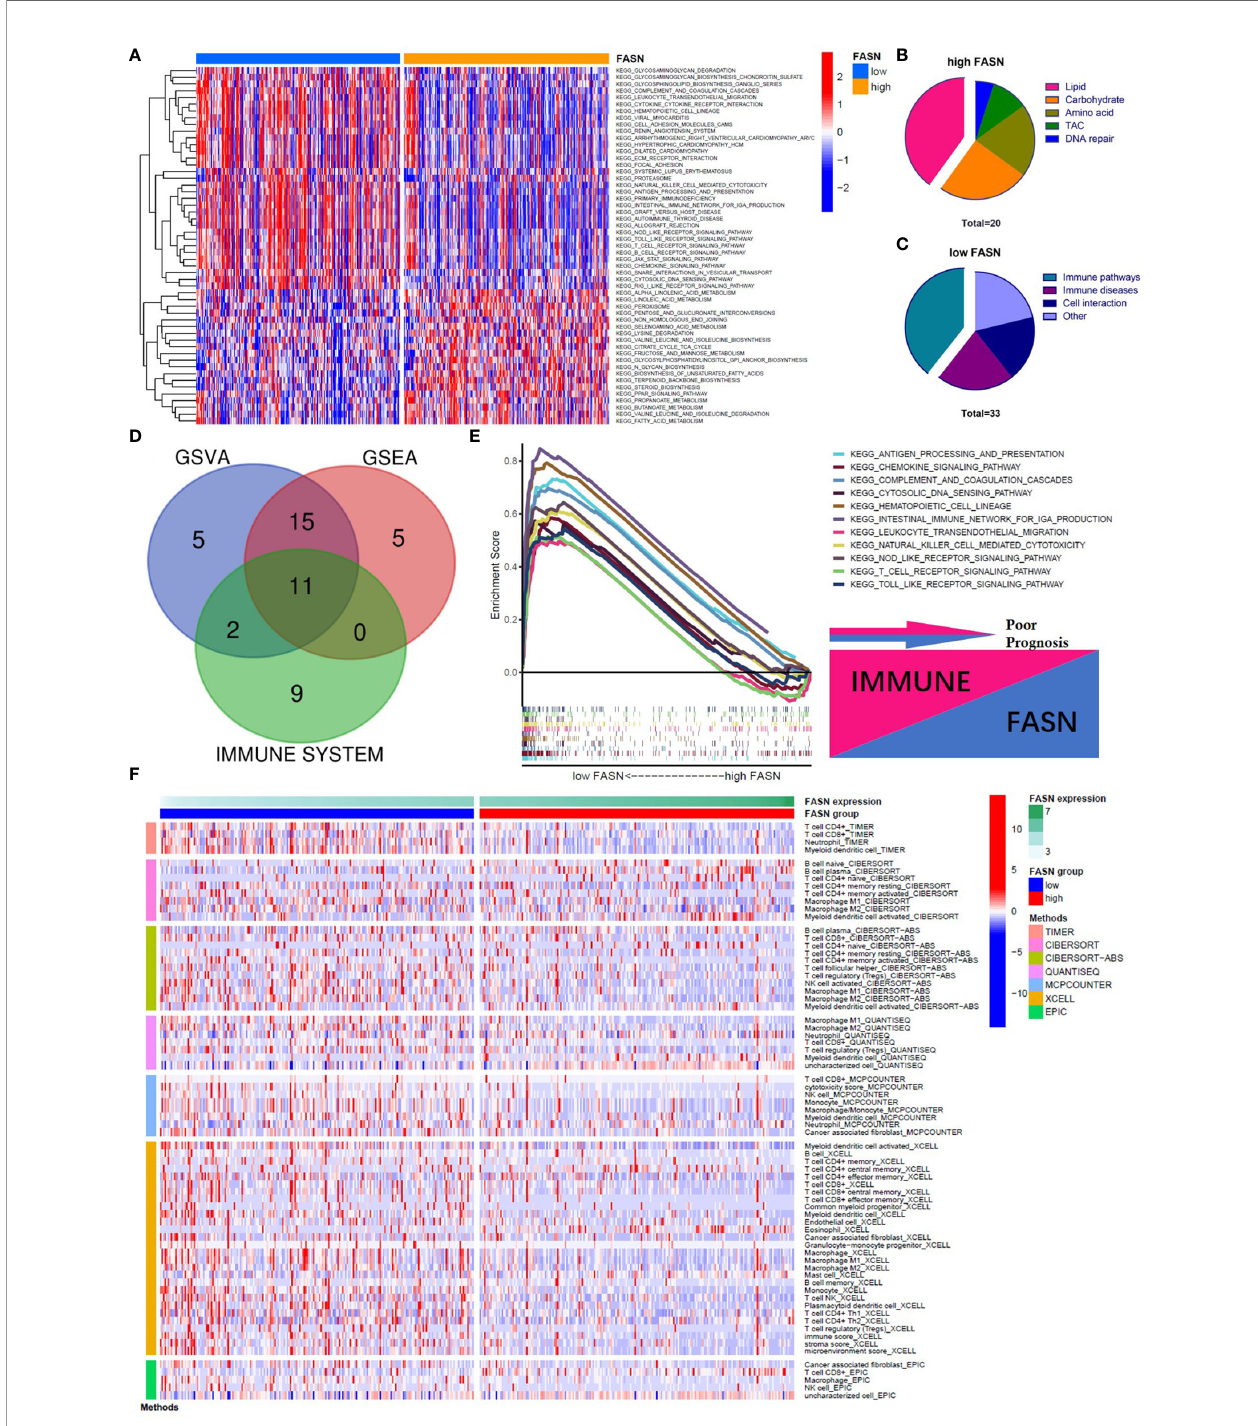
FIGURE 4 | Function analysis of FASN. (A) Heatmap of KEGG enrichment for the low- and high-FASN groups in GSVA (p<0.05). (B) Types of KEGG pathways enriched in the high-FASN group. (C) Types of KEGG pathways enriched in the low-FASN group. (D) Venn plot of pathways enriched in low-FASN group. (E) Gene enrichment of the 11 selected immune pathways in GSEA. (F) Heatmap of immune in fi ltration between low- and high-FASN groups by seven algorithms